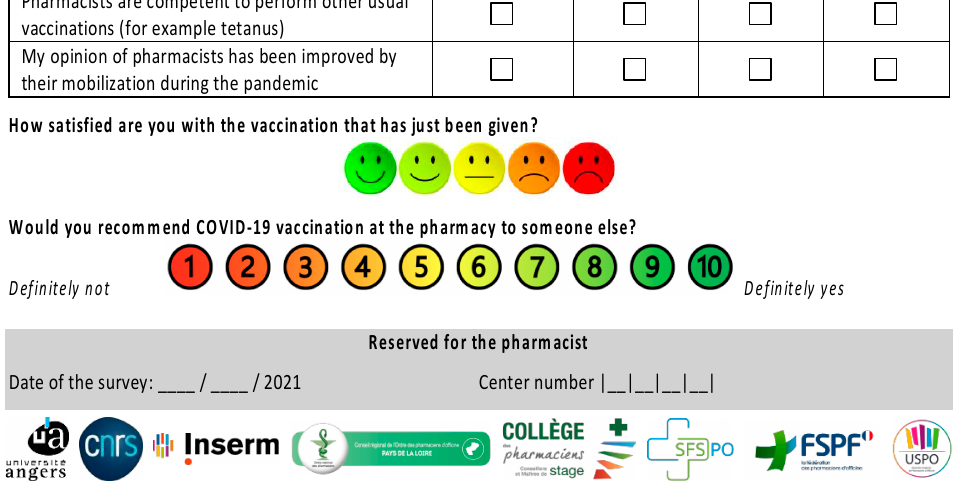
Figure A2. English Translation of PharmaCoVax